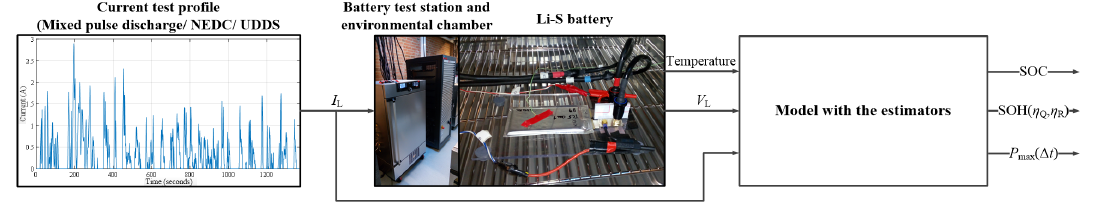
Figure 2. Test procedure